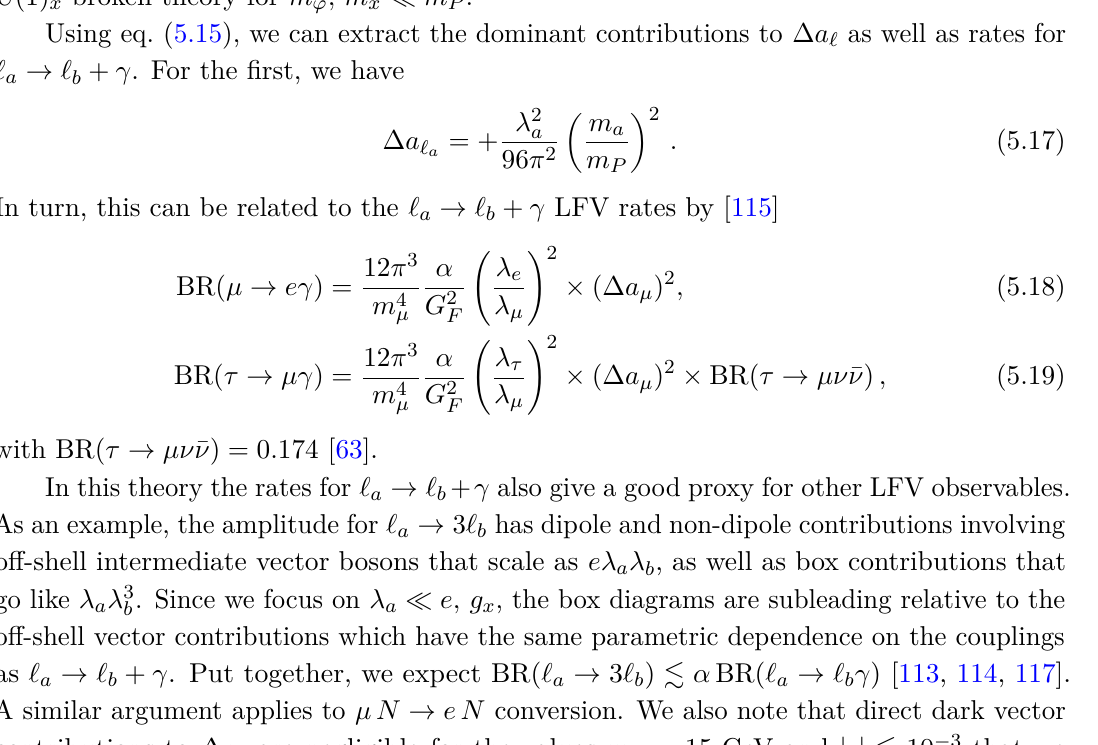
Figure 5 . Charged lepton observables ∆ a e,µ and BR ( µ → eγ ) in the lepton mixing model as a function of λ µ assuming universal ( λ e = λ µ ) or MFV-inspired ( λ e = ( m e /m µ ) λ µ ) couplings. For each observable, the solid, dashed, and dotted lines correspond to m P = 100 , 200 , 400 GeV . impact of m and m is seen in the loop function, and eq. (5.16) shows that the result P φ is independent of m for m 2 (cid:29) m 2 as claimed. We find the same leading result in φ P φ